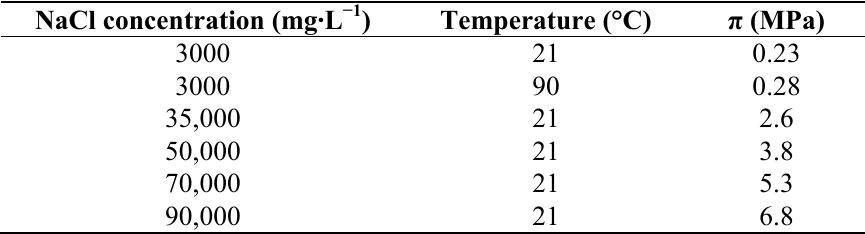
Table 2. Osmotic pressures determined by Equation (1) for the conditions used in this